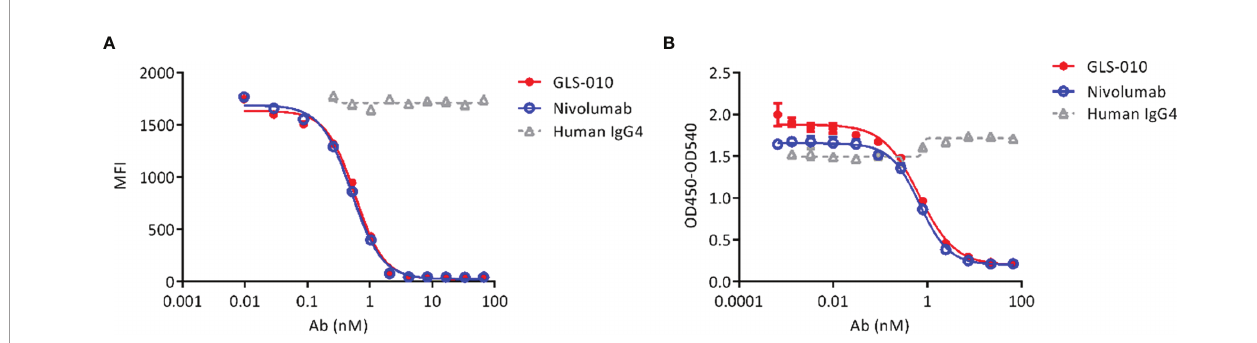
FIGURE 2 | GLS-010 blocks the binding of PD-1 ligands to PD-1. (A) Blocking the binding of PD-L1 with PD-1 by GLS-010 and nivolumab in CHO-S cells by FACS. (B) Blocking the binding of PD-L2 with PD-1 by GLS-010 and nivolumab by ELISA.